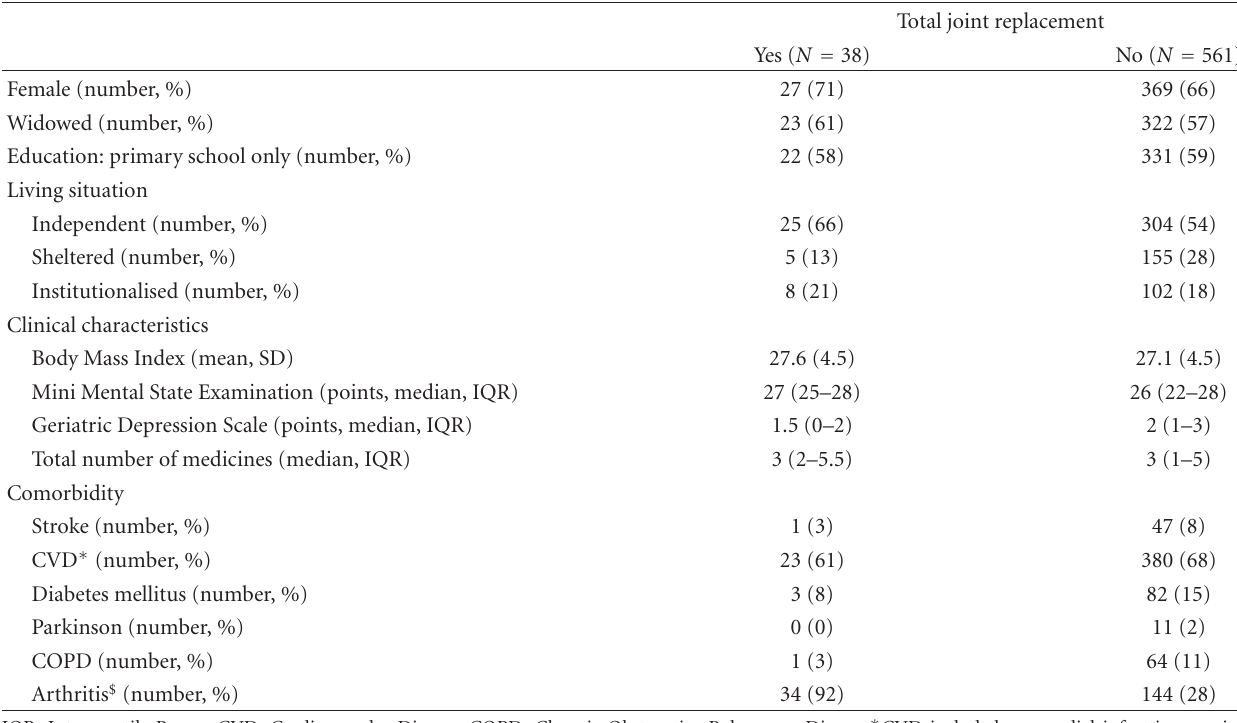
Table 1: Baseline characteristics of participants aged 85 years with and without total joint replacement in the